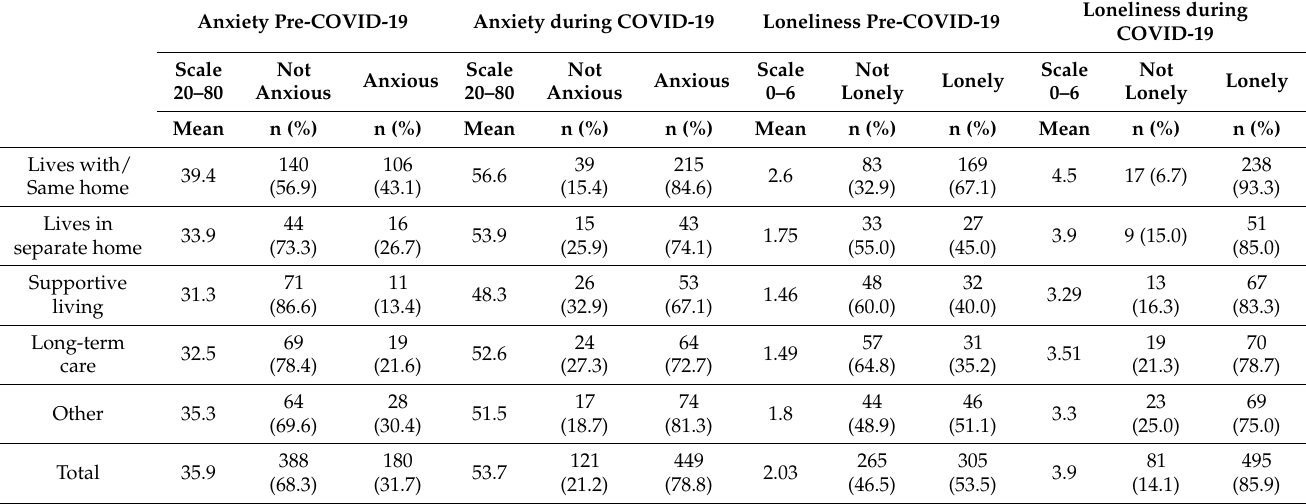
Pre-COVID-19, 31.7% of family caregivers were anxious and 53.5% were lonely. During COVID-19, the proportion who were anxious rose to 78.8% and those who were lonely to 85.9% (see Table 5). On the one-way between-groups analysis to explore the impact of care receiver’s residence, we found a statistically significant difference in anxiety ( p < 0.001) and loneliness ( p < 0.001) (see Figure 5). Effect size calculated using eta squared was small, 0.04 for anxiety and 0.01 for loneliness. Post-hoc comparisons using the Tukey’s-Kramer test (Dunnet t, 2-sided) indicates anxiety was significantly different between those living with the receiver (M = 56.6, SD = 14.2), receivers who lived in supportive living (M = 48.3, SD = 13.5) while similar to those living in a separate community home (M = 53.9, SD = 15.3), in long-term care (M = 52.6, SD = 16.7) and other situations (M = 51.5, SD = 13.7). Table 5. Anxiety and loneliness retrospectively before and during COVID-19: Means and dichotomized proportions by receivers’